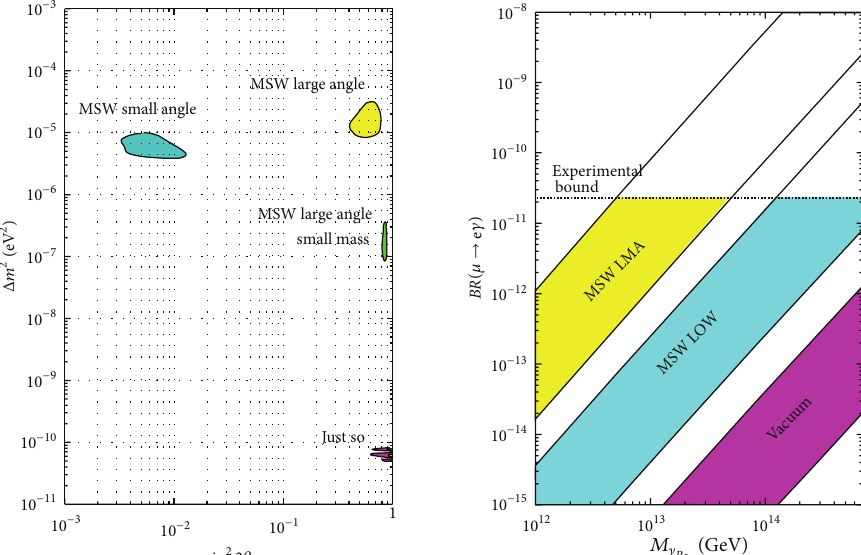
Figure 6: Predictions of 𝜇 → e 𝛾 branching ratio as a function of the right-handed gauge singlet ] 𝑅 ofthesolarneutrinoproblem,shownintheleftplot(from[74]).AftertheSNOandKamlandresults,onlyafractionofLMAsolutionsurvived, while the other solutions are completely ruled out. The line “Experimental Bound” is the limit set by the MEGA experiment in 2002 [88, 89].